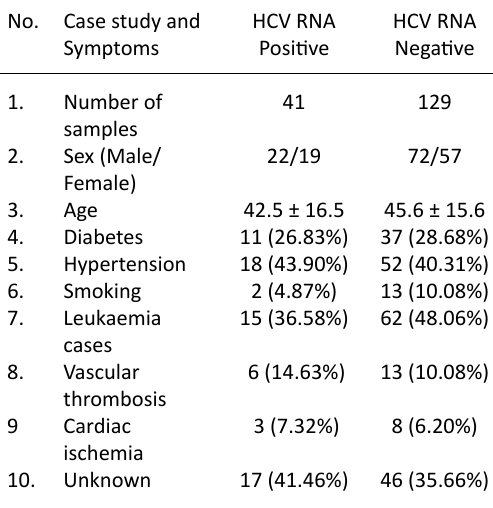
Table 1. Demographic data and Symptoms wise